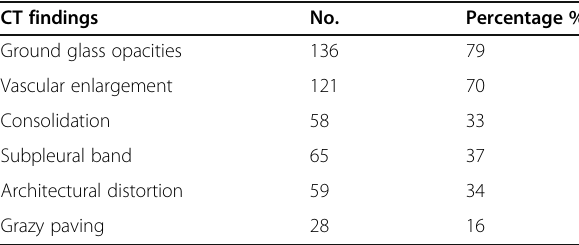
Table 2 Spectrum of CT findings in patients with COVID-19 pulmonary infection